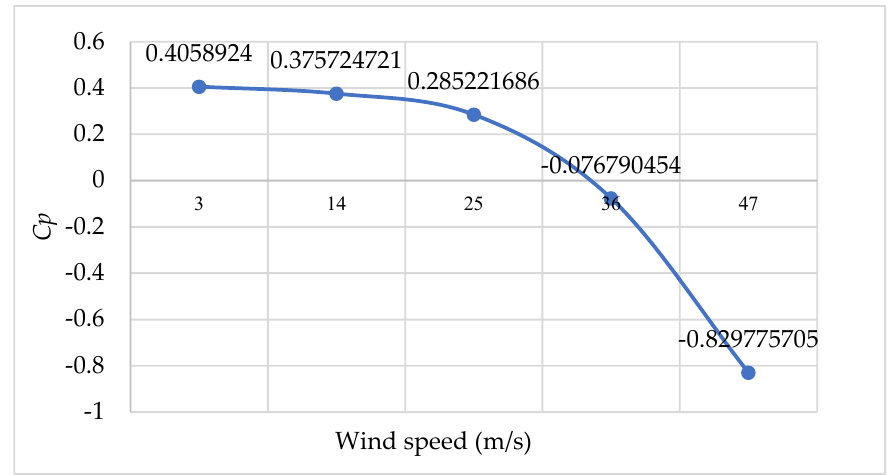
Figure 14. Turbine power coefficient versus the wind speed at different pitch angle adjustments.